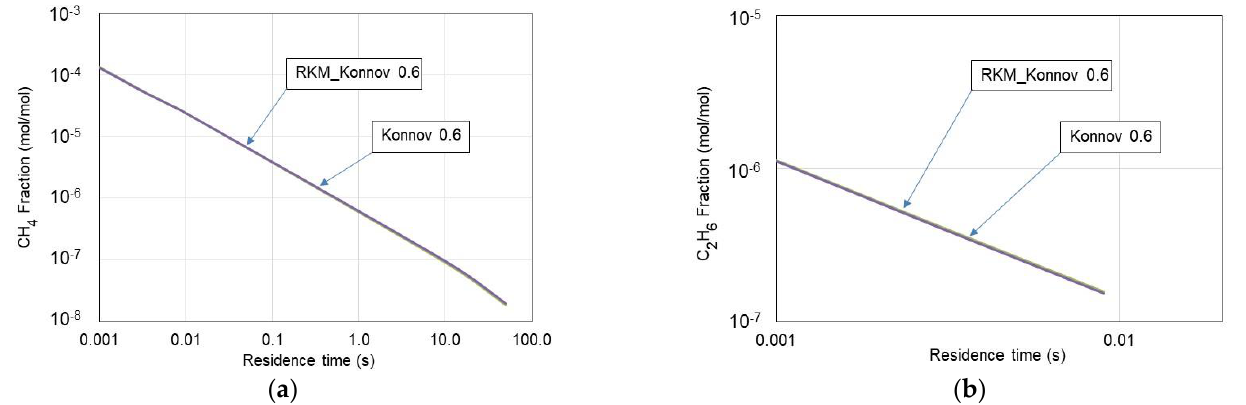
Figure 3. CH 4 ( a ) and C 2 H 6 ( b ) volume fractions vs. residence time in the PSR.